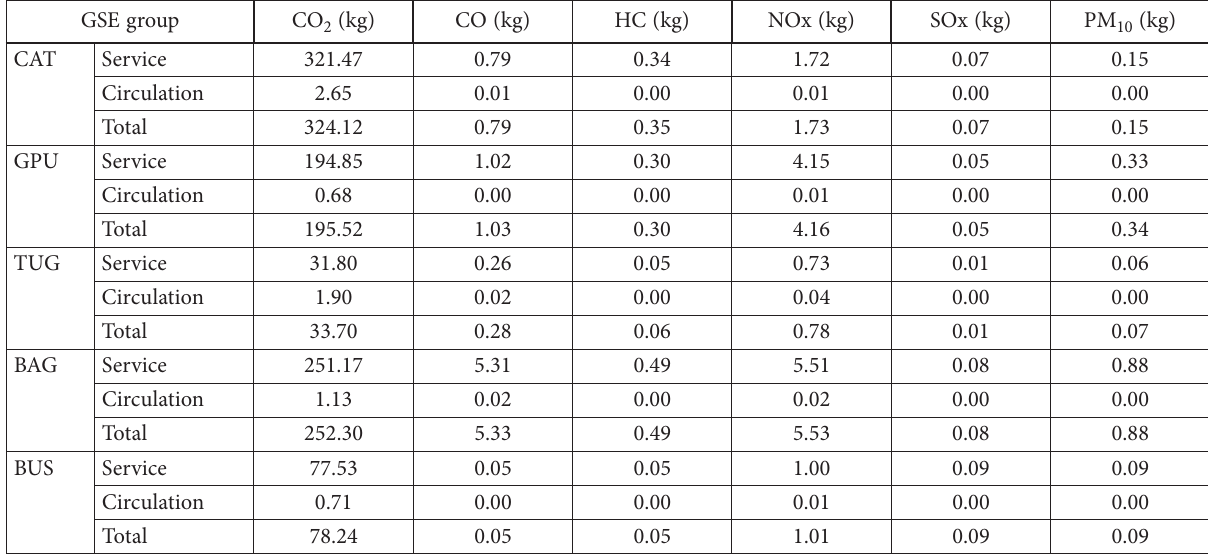
Table B1. Emissions according to service and circulation of all the analyzed gases per GSE group (source: authors) GSE